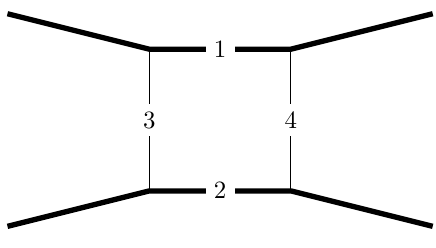
Figure 8. Top level topology at one-loop. Indices correspond to the propagators listed in eq. (4.34). The power counting rules for propagators and integration measure in the potential re- gion